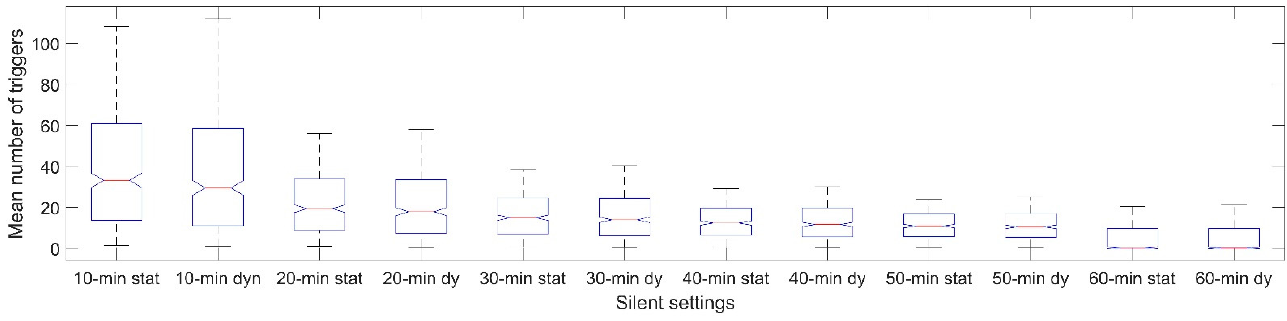
Figure 4. Mean number of AddHRVr triggers for 6 different silent settings of the algorithm (from 10 to 60 min) for the static and the dynamic algorithm, separately.